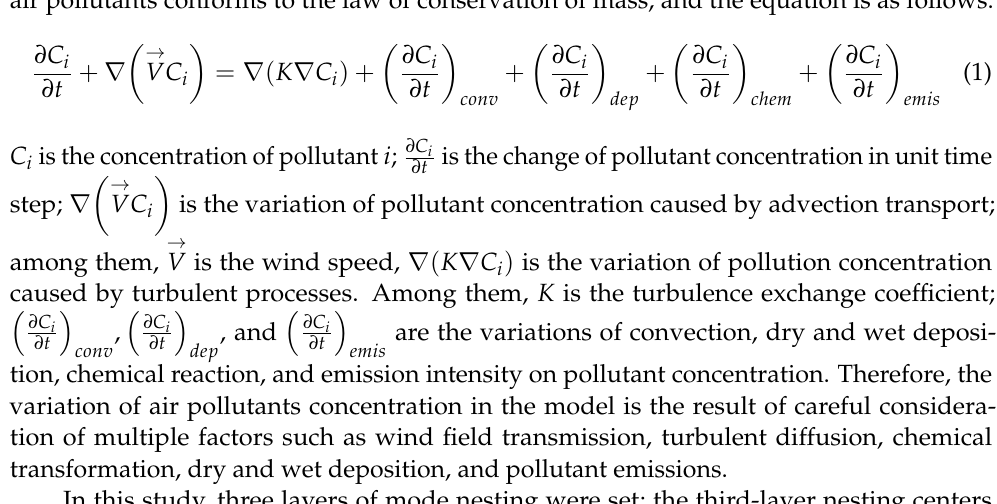
Table 1. Meteorological initial and boundary conditions were obtained from NCEP GDAS Final Analysis data with a spatial resolution of 0.25 ◦ × 0.25 ◦ for January–February 2019 and January—February 2020 [23]. Biogenic emission data used natural gas and